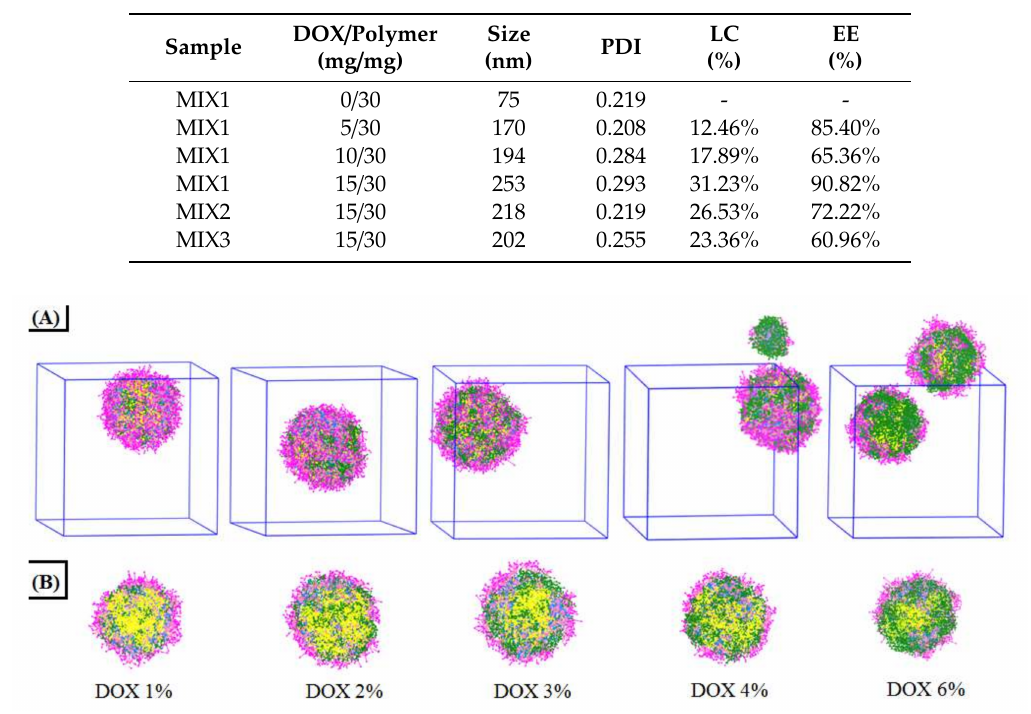
Figure 4. Equilibrium states ( A ) and cross-setion views ( B ) of the DOX-loaded mixed micelles at di ff erent DOX concentrations.